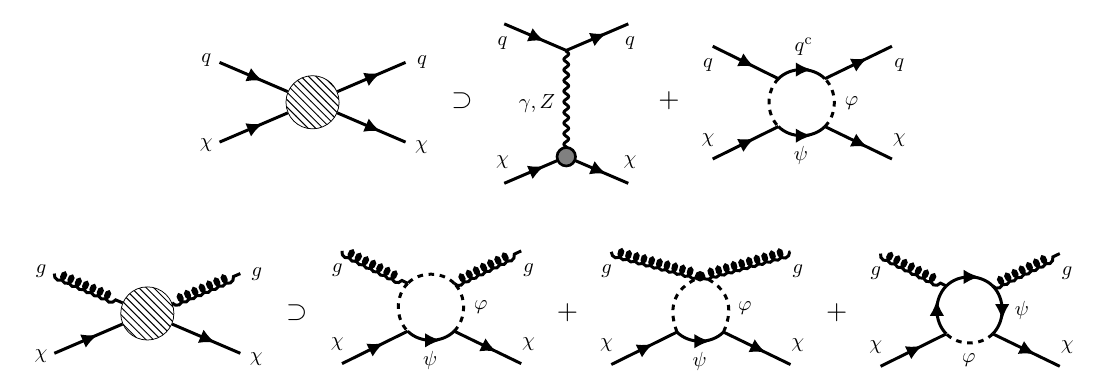
Figure 18 . Loop-induced scattering off quarks or gluons, leading to scattering with nuclei. The small blob in first diagram denotes an insertion of the electromagnetic moment (one-loop) effective